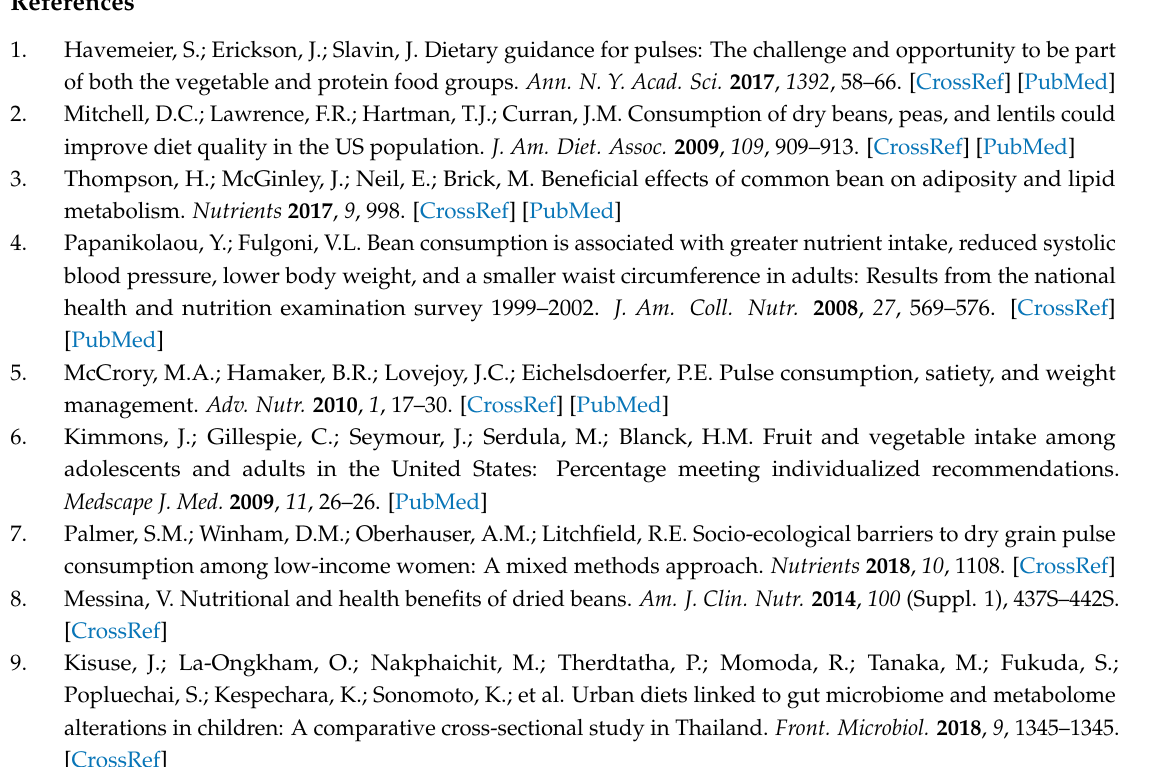
Table S1. Navy bean powder food metabolome. Table S2. Metabolites with statistical significance between control diet consumers at 4 weeks compared to baseline. Figure S1: Study design/ consort